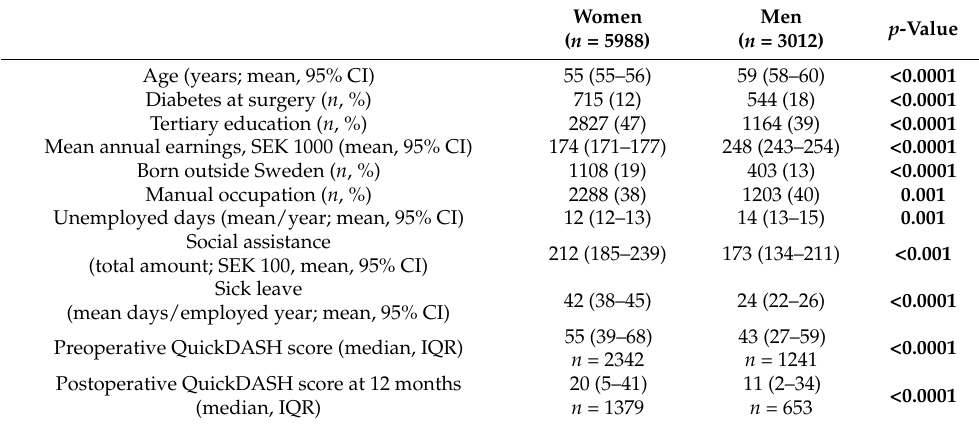
Table 1. Socioeconomic factors in 9000 patients with surgically treated carpal tunnel